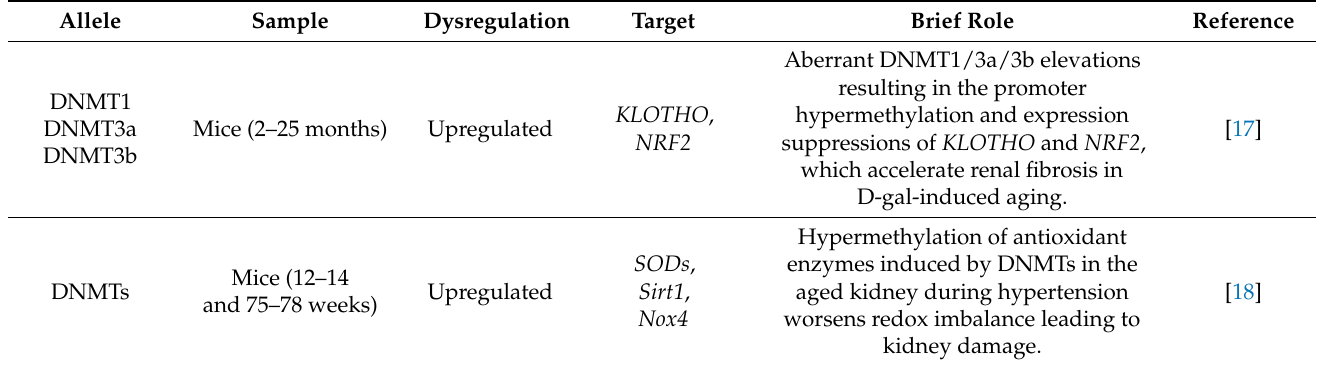
Table 1. DNA methylation in age-related kidney